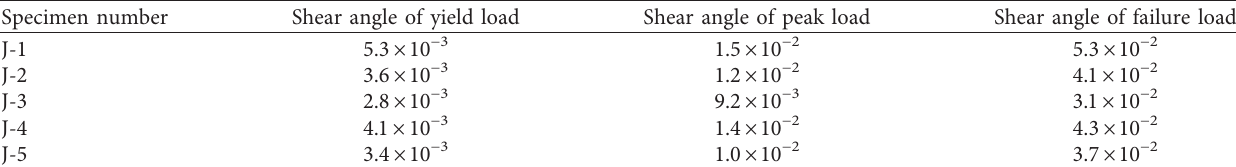
Table 8: Shear angle of the core region.